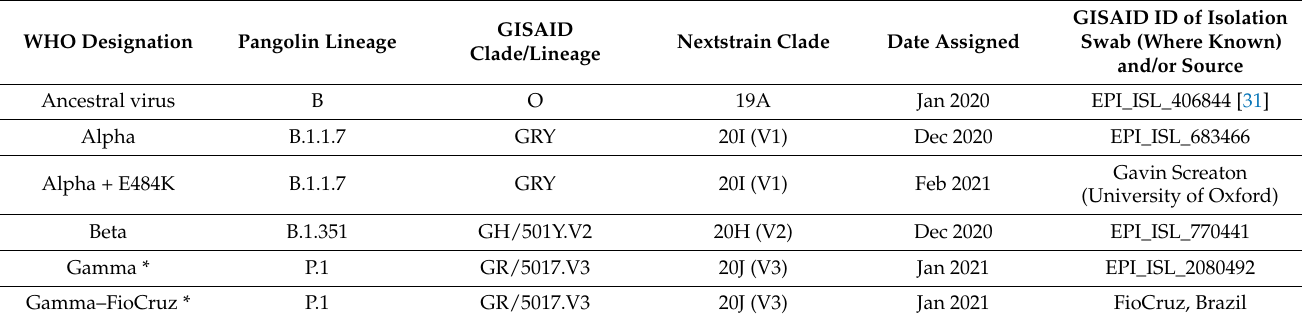
Table 1. SARS-CoV-2 variants used in this